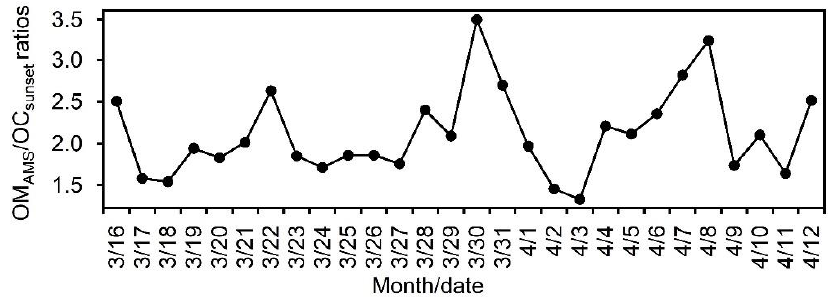
Figure 7. Temporal variations of mass concentration ratios of organic matter (OM AMS ) to organic carbon (OC Sunset ).